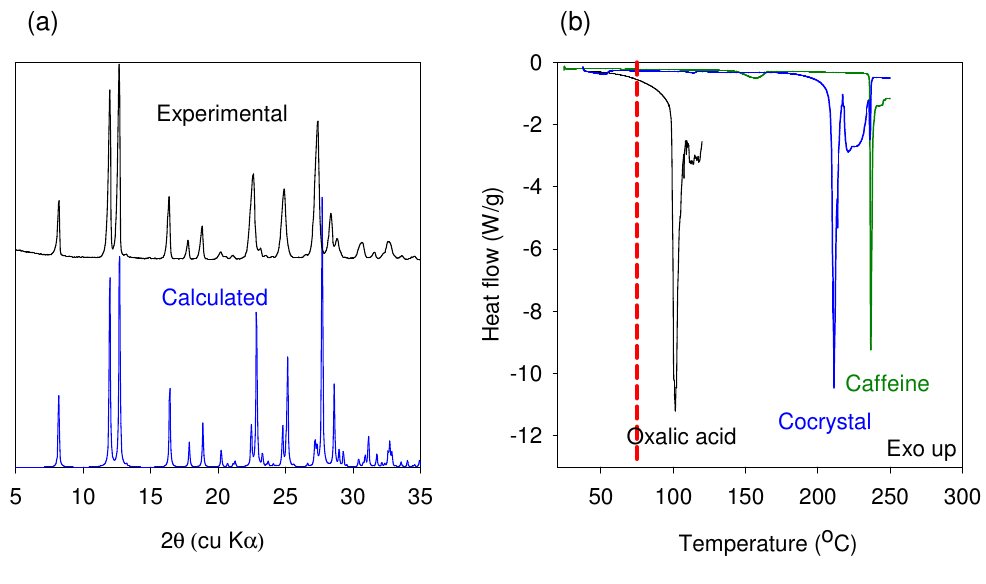
Figure 6. (a) Comparison of experimental and calculated XRPD profiles of caffeine-oxalic acid cocrystal. (b) DSC thermogram showing comparison of oxalic acid dihydrate, anhydrous caffeine, and 2:1 caffeine-oxalic acid cocrystal. The dotted line in Figure (b) represents the extrusion